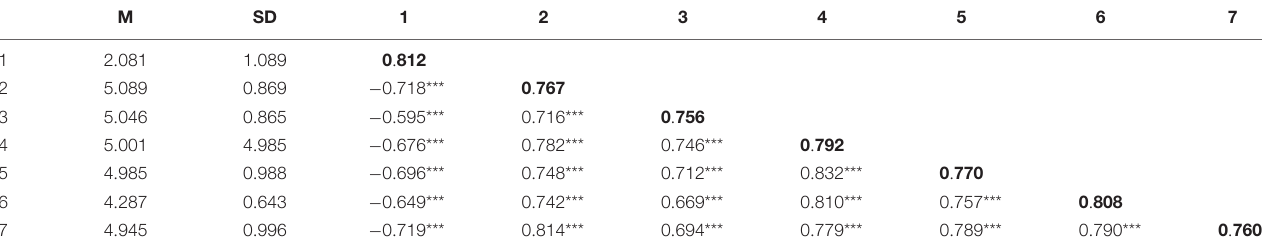
TABLE 1 | Descriptive analysis and correlation